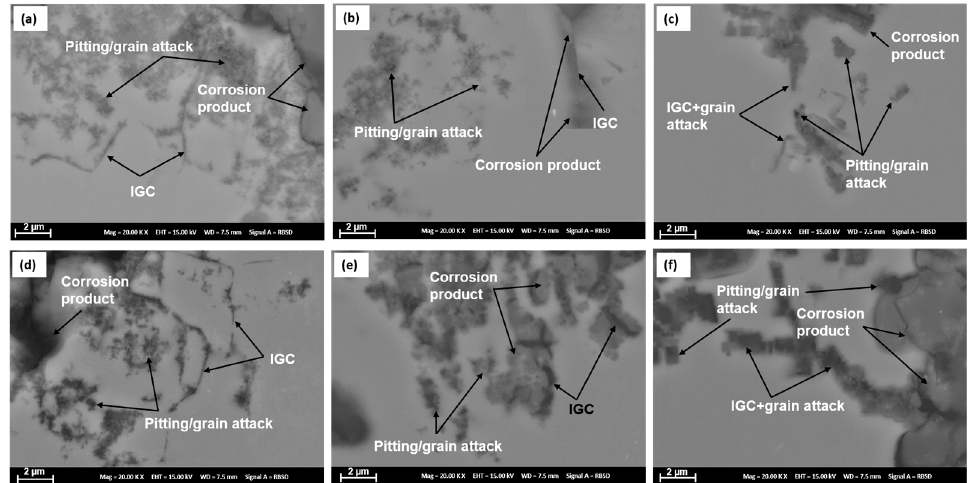
Figure 16. SEM images of the corrosion front showing observed corrosion mechanisms: ( a ) 7449-T4, ( b ) 7449-T6, ( c ) 7449-T76, ( d ) 7449+Cr-T4, ( e ) 7449+Cr-T6, ( f ) 7449+Cr-T76.